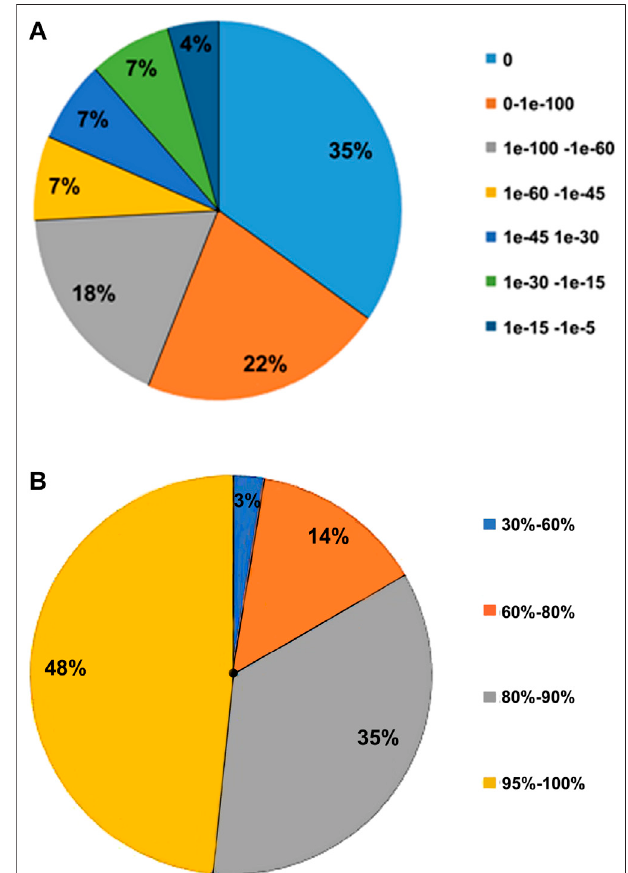
FIGURE 1 | Characteristics of sequence homology of unigenes against the NR database. (A) - E-value distribution of BLAST hits for each unigene. (B) Similarity distribution of BLAST hits of each